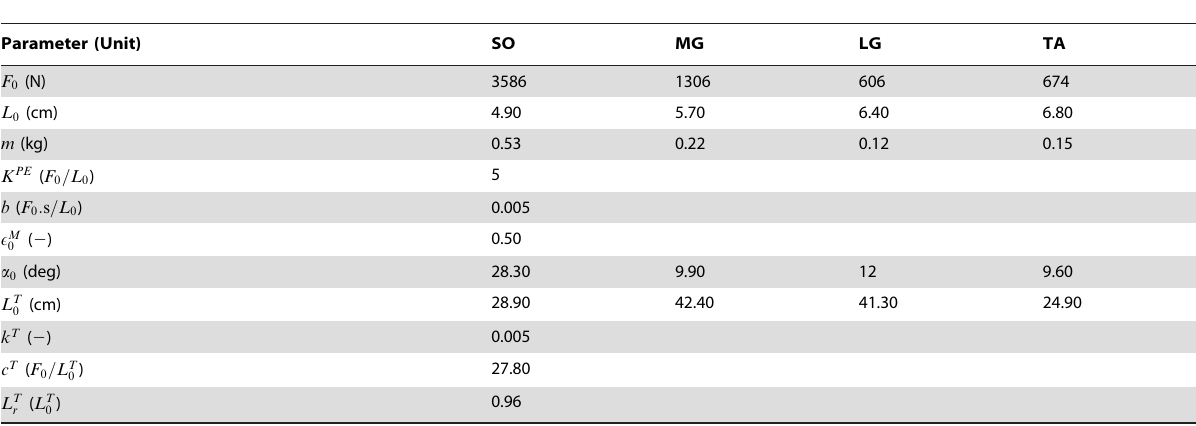
Table 3. Passive parameters of the musculotendon units (MTUs).